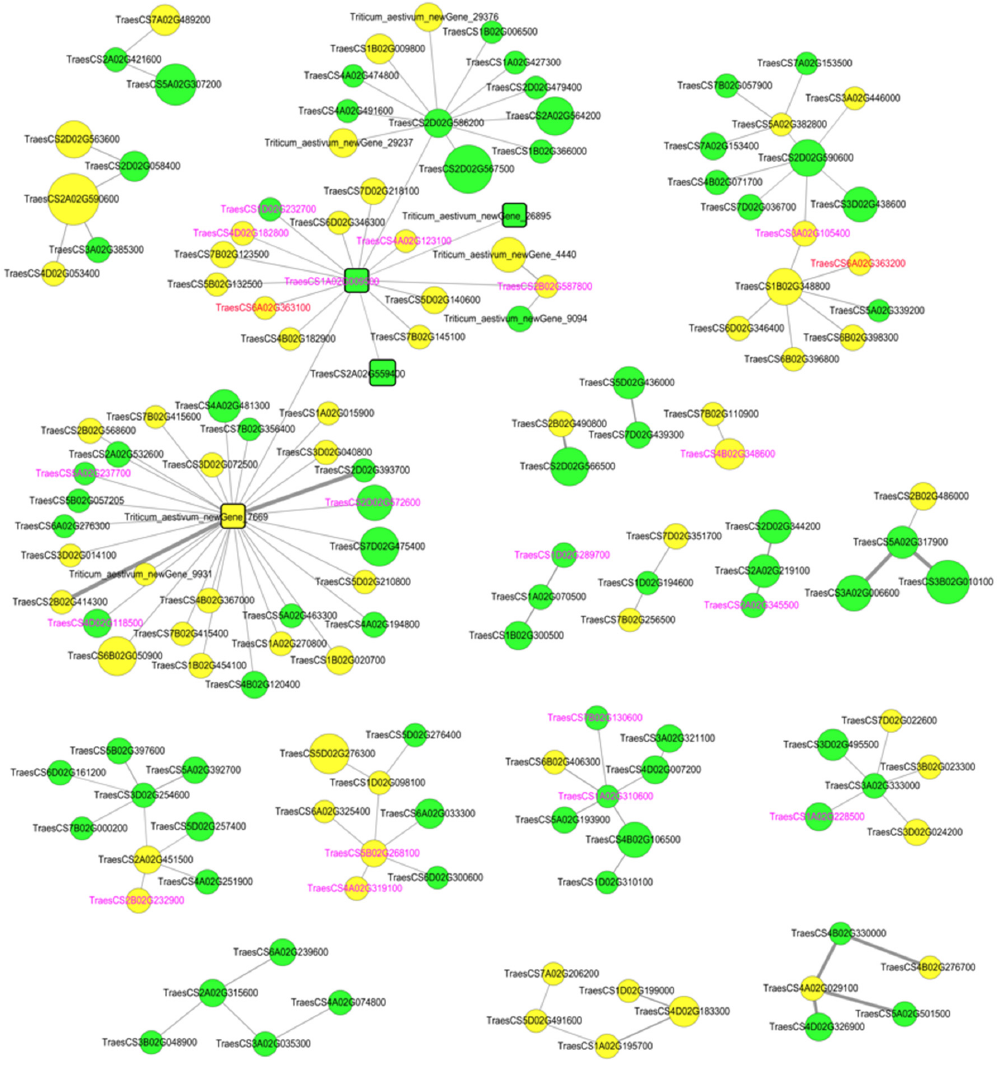
Figure 5. PPI network for DEGs. Note: The circles and rectangles indicate the DEGs and the hub DEGs, respectively, detected in this study, and their size represents the fold change value of these DEGs. The thickness of lines between DEGs indicated the strengthening of their correlation. Green indicates the upregulated DEGs, and yellow indicates downregulated DEGs. The gene name in pur- ple and red indicates these DEG are regulated by methylation, and the gene name in red indicates that the methylation levels in the promoter regions of the corresponding DEGs were significantly different between the CK and SP groups. PPI, Protein – Protein Interaction; DEGs, Differentially Ex- pressed Genes.